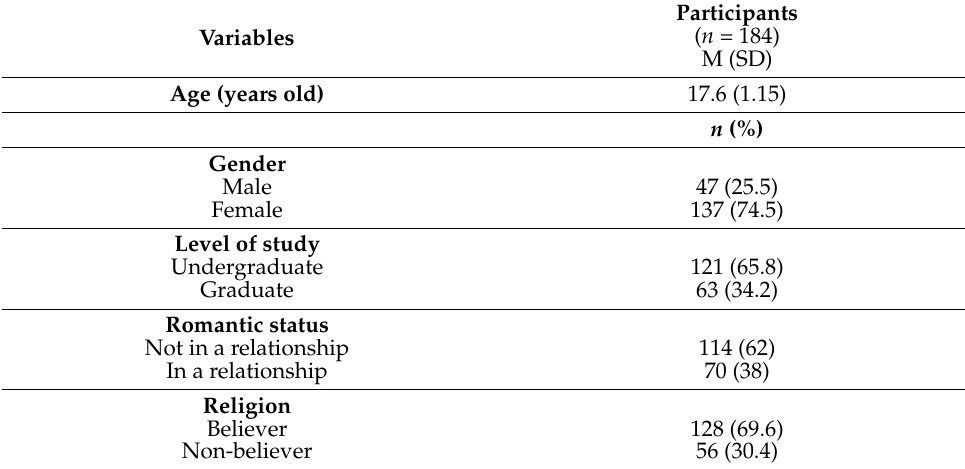
Table 1. Participants’ sociodemographic